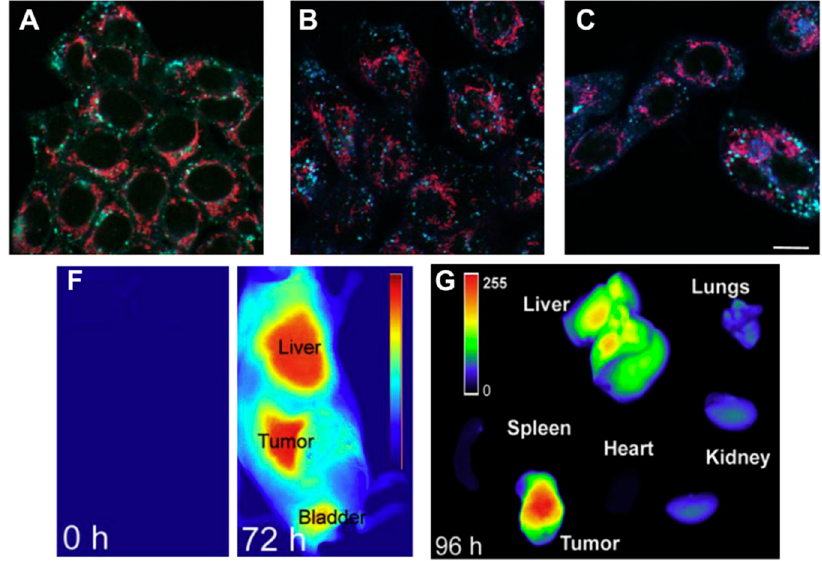
Figure 8. Co-localization of Pc4 loaded MBA-functionalized triple responsive expansile NGs (TRN) (red) in lysosome and mithocondria at 2, 3 and 21 h respectively for ( A ); ( B ) and ( C ). Scale bar in ( C ) is 10 µm. ( F ) Biodistribution of MBA-Pc4-TRN before and 72 h after injection in induced tumor mice; ( G ) “Ex vivo” images 96 h after MBA-Pc4-TRN according to color scale. (Reprinted with permission from reference [148]. Copyright 2014